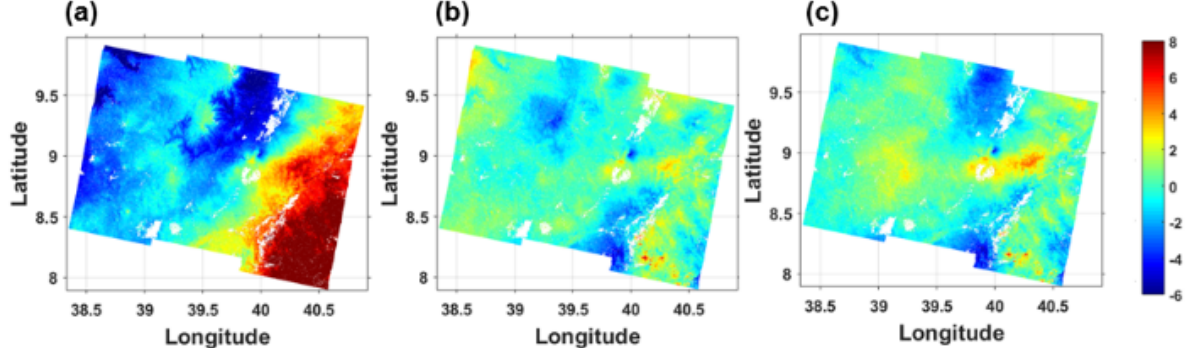
Figure 3. (a) Sentinel-1 interferogram (cm) over Ethiopia, during 28/03/2015-21/04/2015 and interferogram corrected using zenith total delays from (b) HRES-ECMWF and (c)